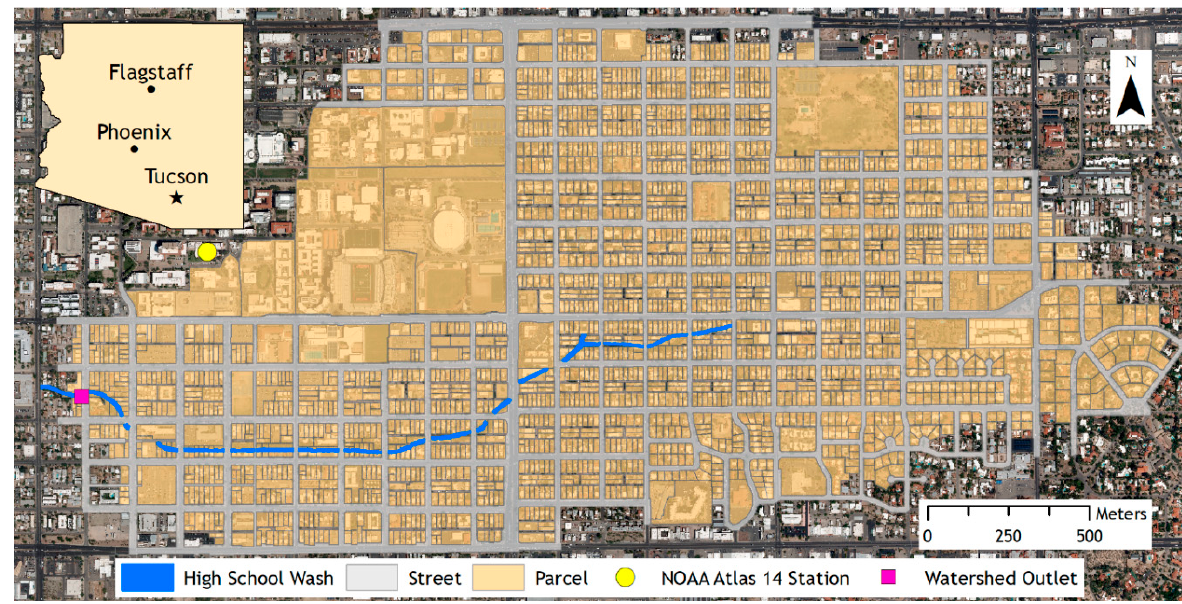
Figure 2. High School watershed comprising of 2177 parcels.